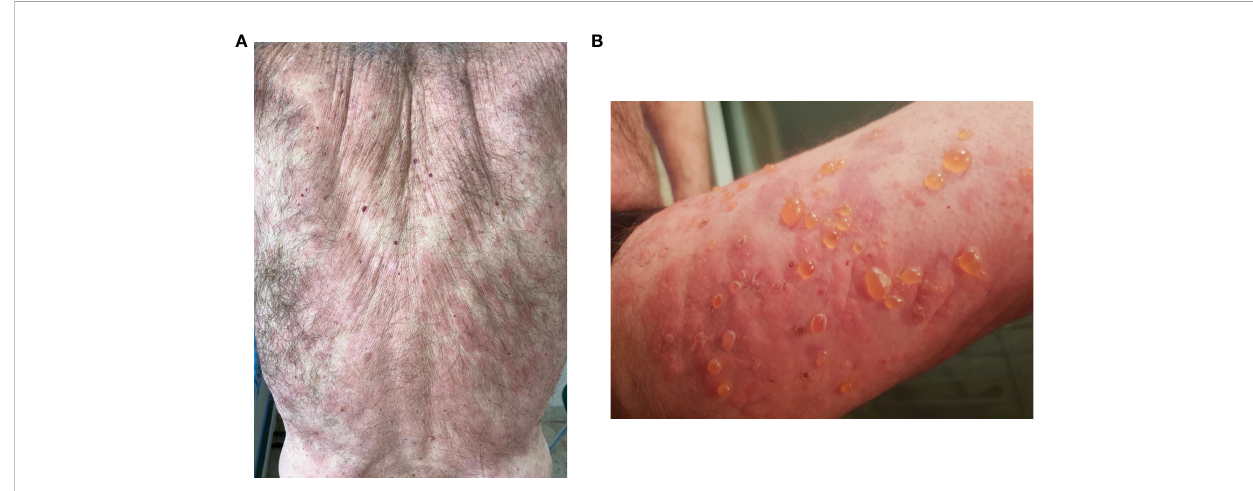
FIGURE 1 Bullous pemphigoid before rituximab in the index case, the 8 th patient. (A) Extensive erythematous patches and plaques on the back. (B) Tense bullae on erythematous skin on the right